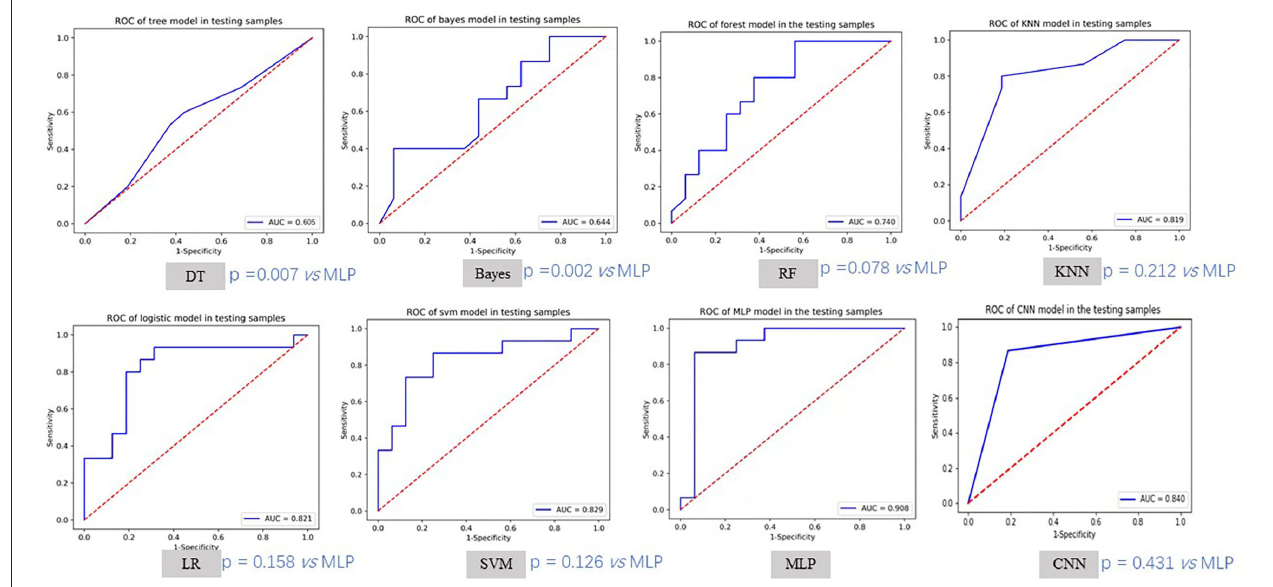
FIGURE 4 | The ROC curves of different models in testing samples. MLP method achieved the best testing AUC. We also compared other methods with MLP using Delong test.